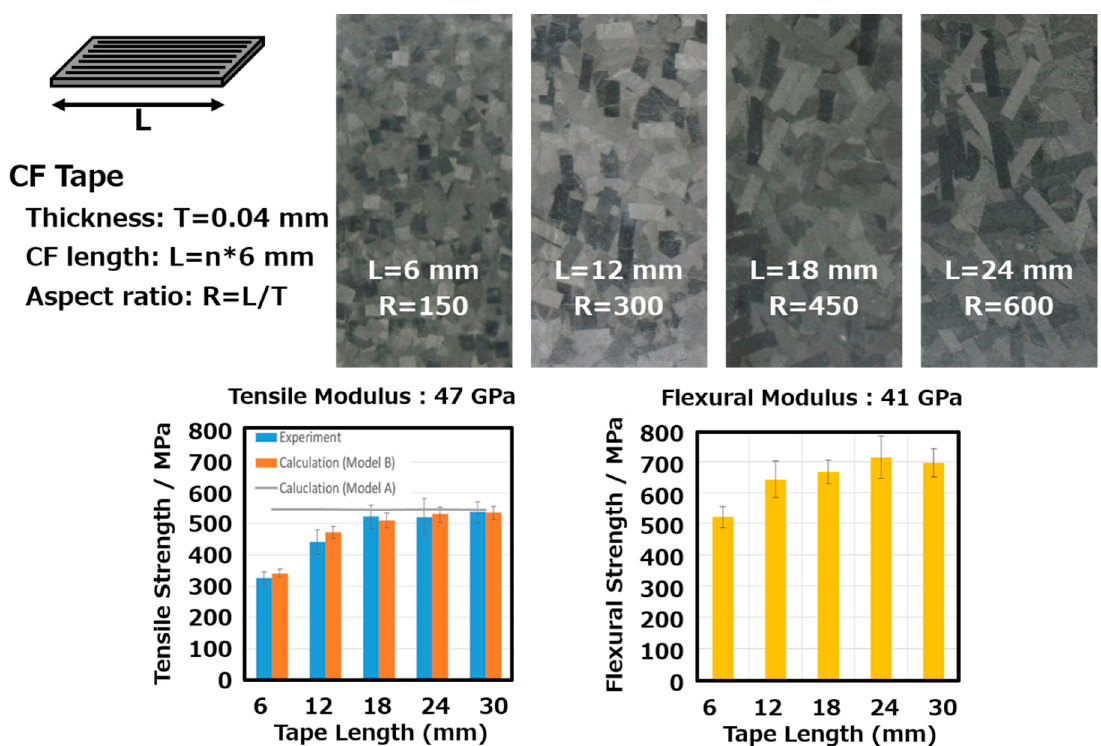
Figure 8. Dependence of the mechanical performance on the tape length: tensile and flexural strengths of ultra-thin CTTs.